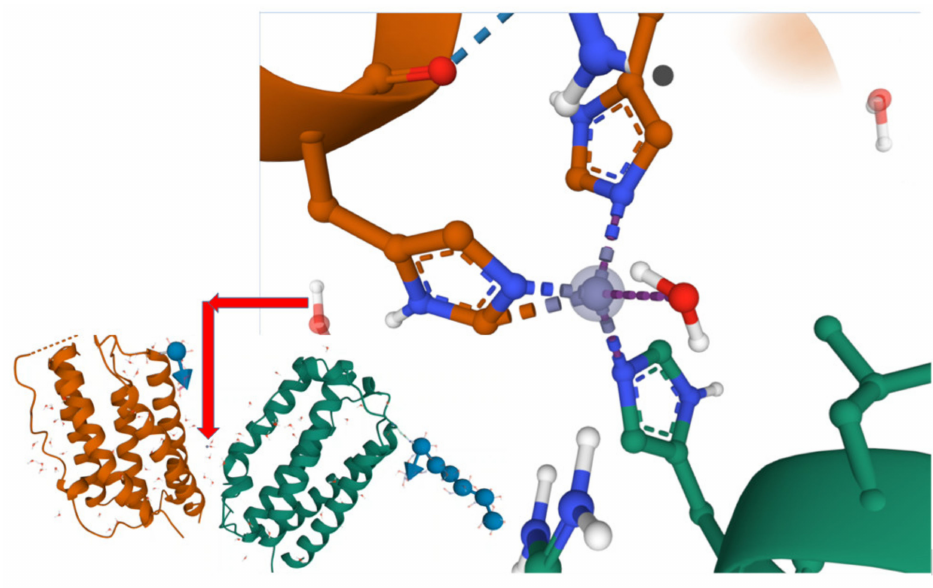
Figure 4. 3D-structure of IFN β -1 with highlighted Zn 2 ± -complex the visualization was performed using software Mol* Viewer for 3D visualization and analysis of large biomolecular structures